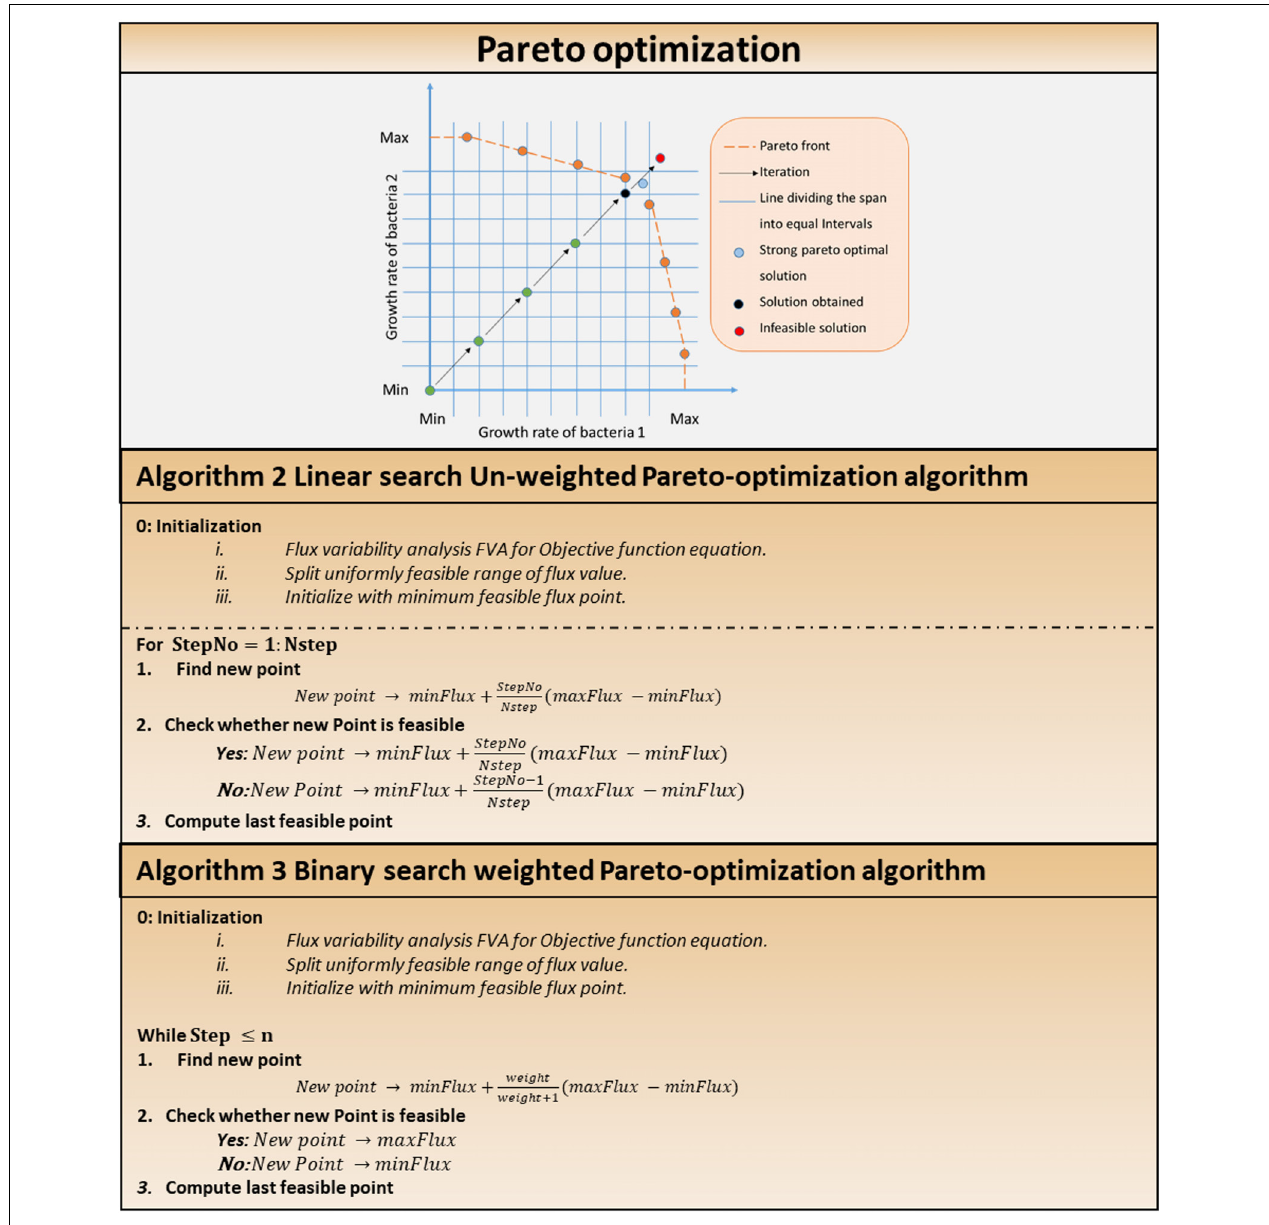
FIGURE 5 | Multi-objective optimization in multi-cellular system. Pareto optimization: pareto optimization search technique. Algorithm 2: linear Search unweighted Pareto optimization algorithm. Algorithm 3: binary Search weighted Pareto-optimization